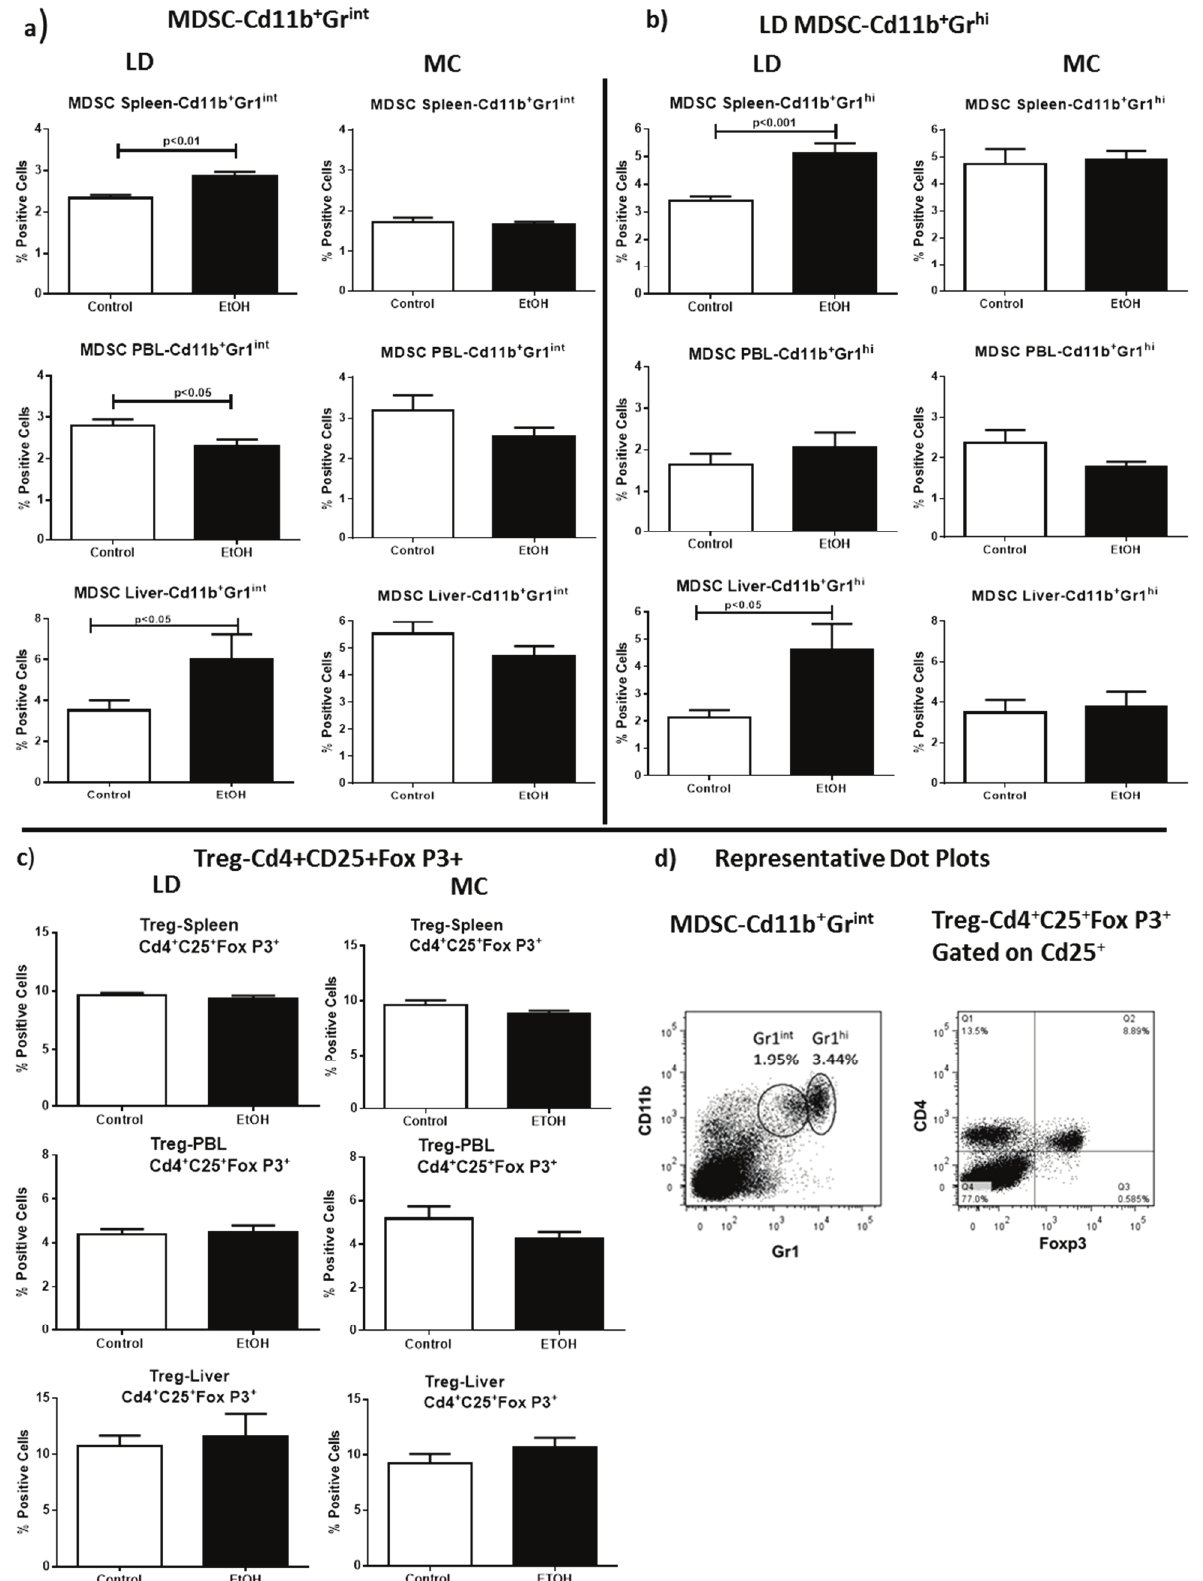
Figure 2. LD Alcohol Feeding Increases MDSC Populations in the Liver and Spleen. ( a ) LD EtOH feeding but not MC feeding induces Cd11b + Gr1 int and ( b ) Cd11b + Gr1 hi MDSC populations in the spleen and liver; ( c ) Cd4 + Cd25 + Foxp3 + Treg populations are unchanged by either EtOH feeding protocol; and ( d ) representative dot